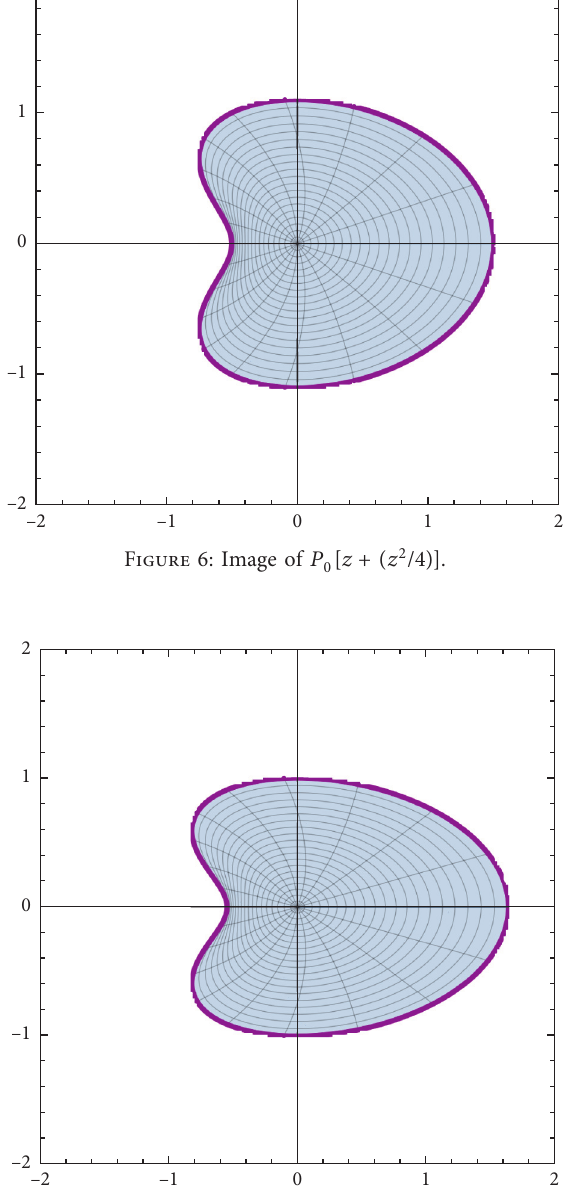
Figure 7: Image of P